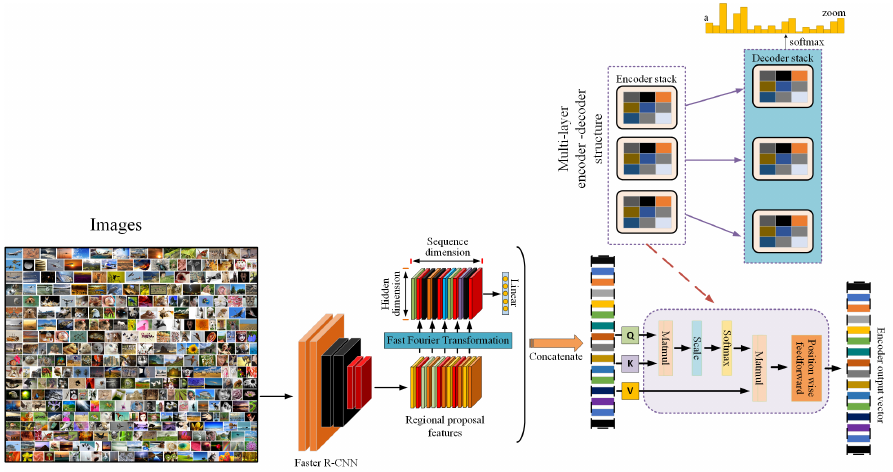
Figure 2. Fourier-enhanced image-captioning framework